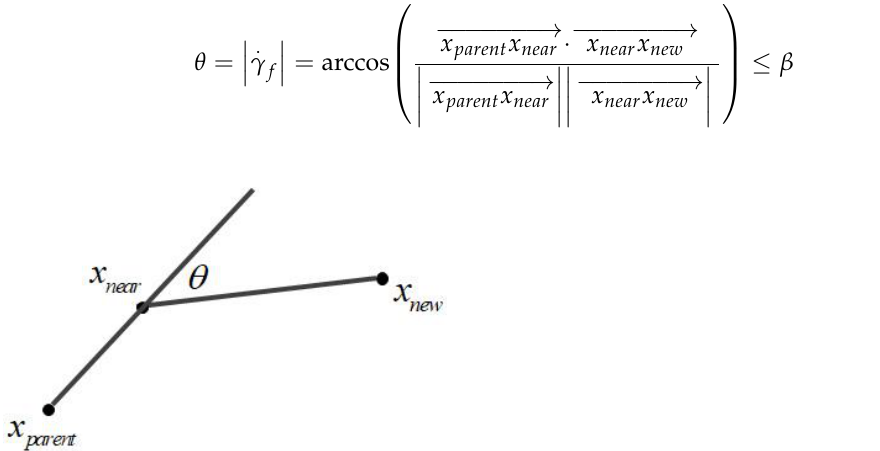
Figure 9. Geometric relation of steering angle constraints.